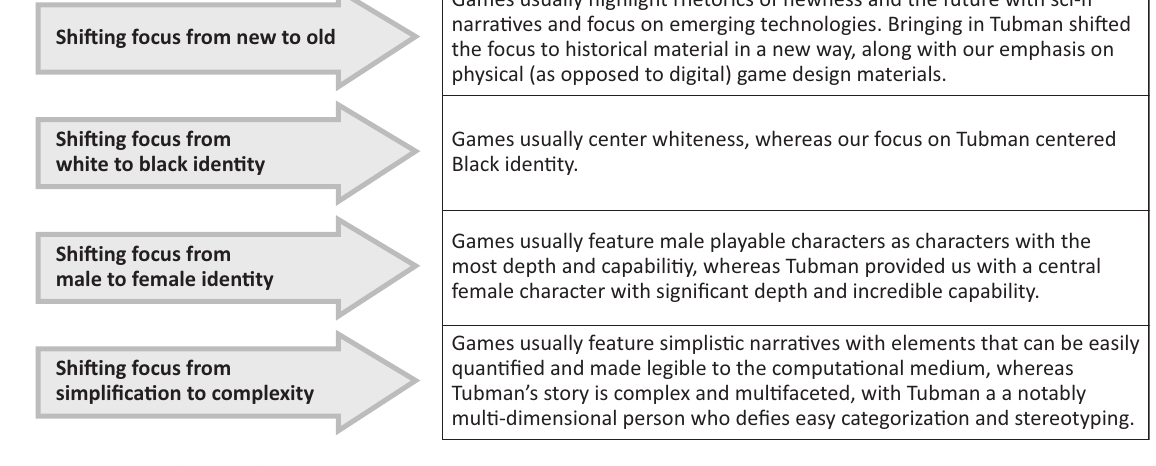
Figure 3. A series of powerful shifts, enabled by Tubman as a catalyst, in our games